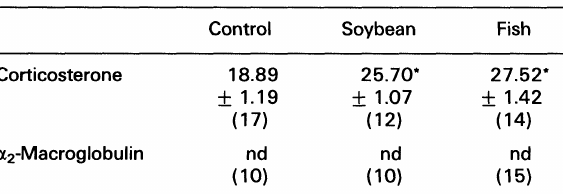
Table 4. Corticosterone (lg/dl) and 2-macroglobulin (a.u.) plasma levels in rats, after 6 weeks of diets